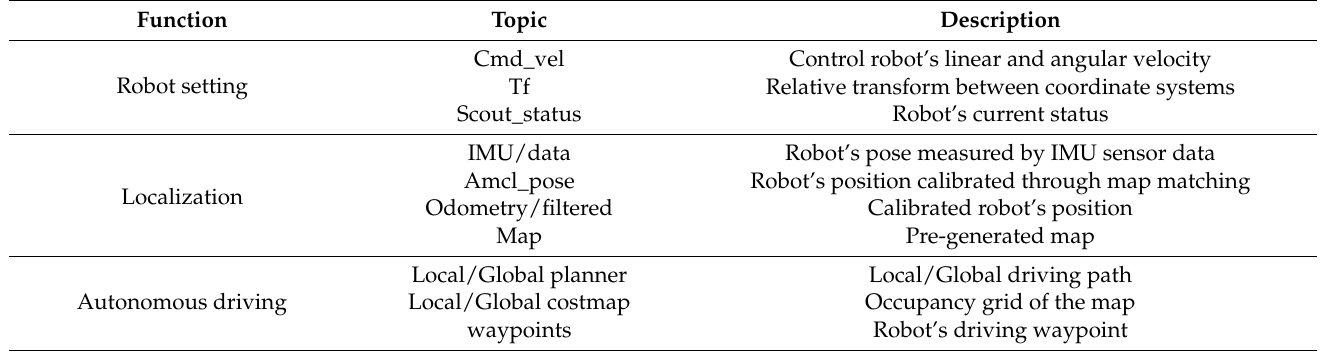
Table 2. Representative ROS topics that make up the autonomous driving robot developed in this